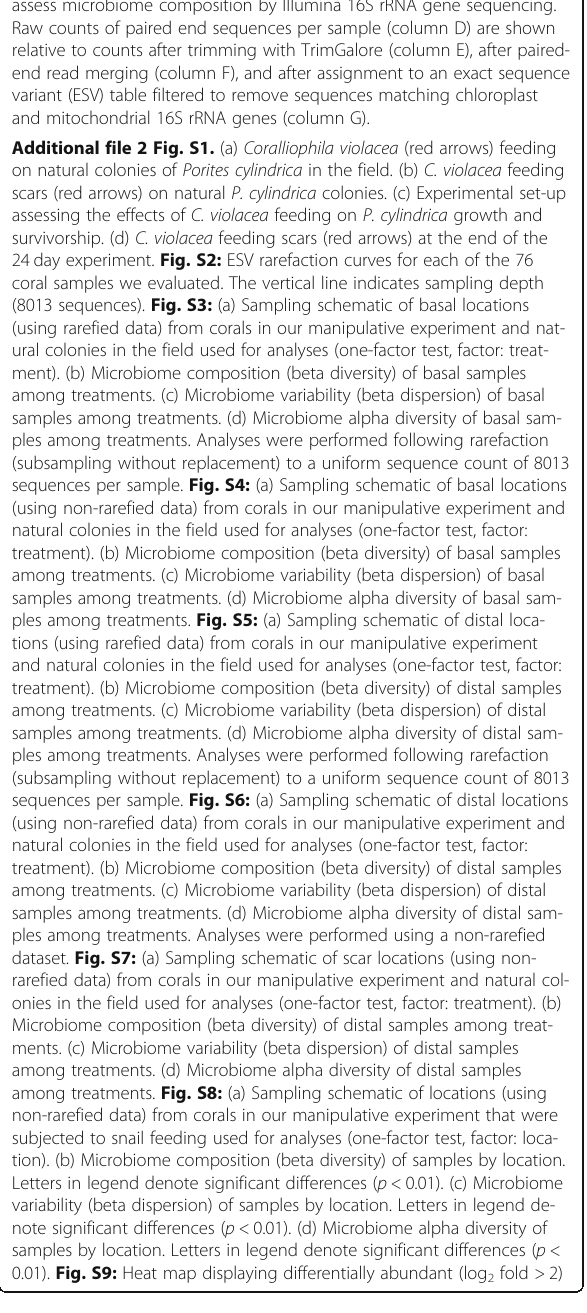
parametric fit. Fig. S10: (a) Sampling schematic of basal and distal loca- tions (using rarefied data) from control corals in our manipulative experi- ment that lacked snails used for analyses (one-factor test, factor: location). (b) Microbiome composition (beta diversity) of samples by location. (c) Microbiome variability (beta dispersion) of distal samples among treat- ments. (d) Microbiome alpha diversity of distal samples among treat- ments. Analyses were performed following rarefaction (subsampling without replacement) to a uniform sequence count of 8013 sequences per sample. Fig. S11: (a) Sampling schematic of basal and distal locations (using non-rarefied data) from control corals in our manipulative experi- ment that lacked snails used for analyses (one-factor test, factor: location). (b) Microbiome composition (beta diversity) of samples by location. (c) Microbiome variability (beta dispersion) of distal samples among treat- ments. (d) Microbiome alpha diversity of distal samples among treat- ments. Fig. S12: (a) Sampling schematic of locations (using non-rarefied data) from natural coral colonies that were subjected to snail feeding used for analyses (one-factor test, factor: treatment). (b) Microbiome com- position (beta diversity) of samples by location. Letters in legend